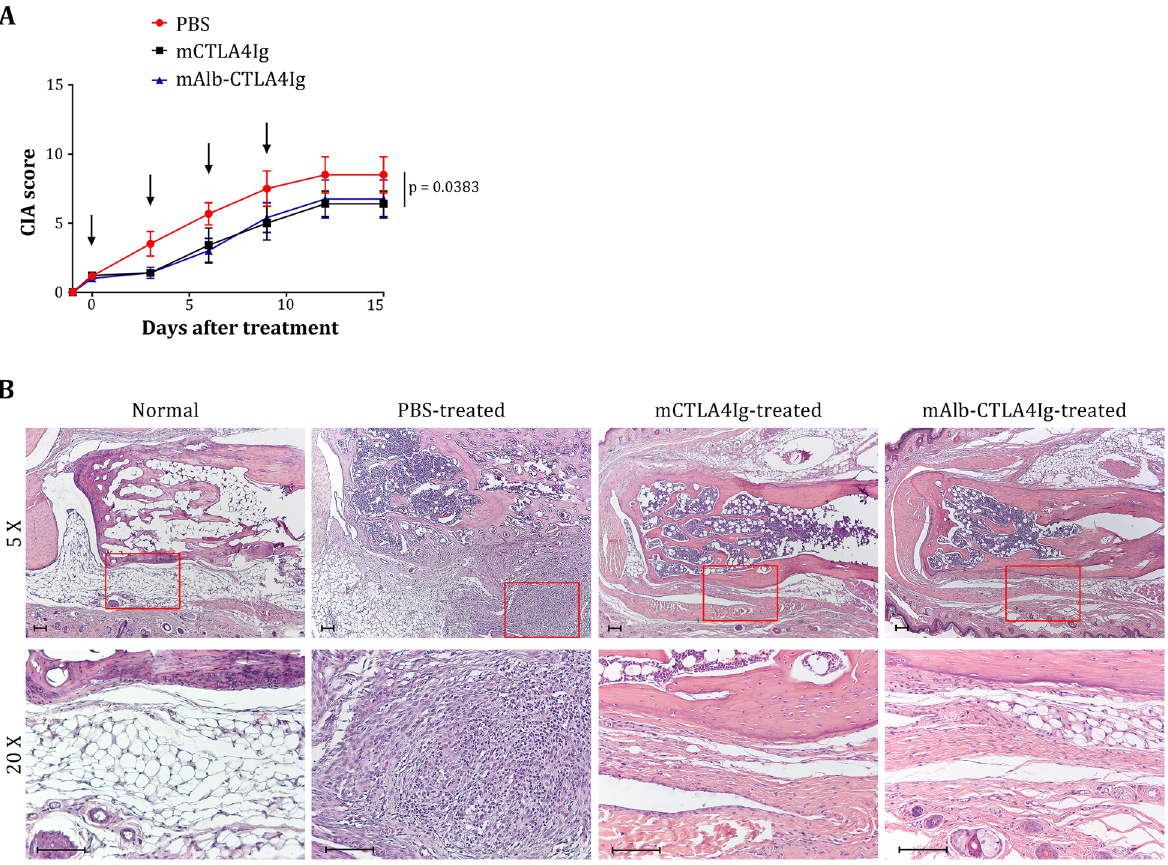
Fig. 7 Efficacy of mAlb‑CTLA4Ig for treating mouse collagen‑induced arthritis. A Treatment efficacies of mAlb‑CTLA4Ig and mCTLA4Ig on CIA. Arrows indicate the time of treatments. Representative data from two independent experiments are shown. B Histopathological microphotographs of the paws of a normal mouse or CIA mice that received different treatments. Areas enclosed by red rectangles ( shown at higher magnification ( 20 objective, lower row) for inflammatory cells. Scale bar: 100 ×